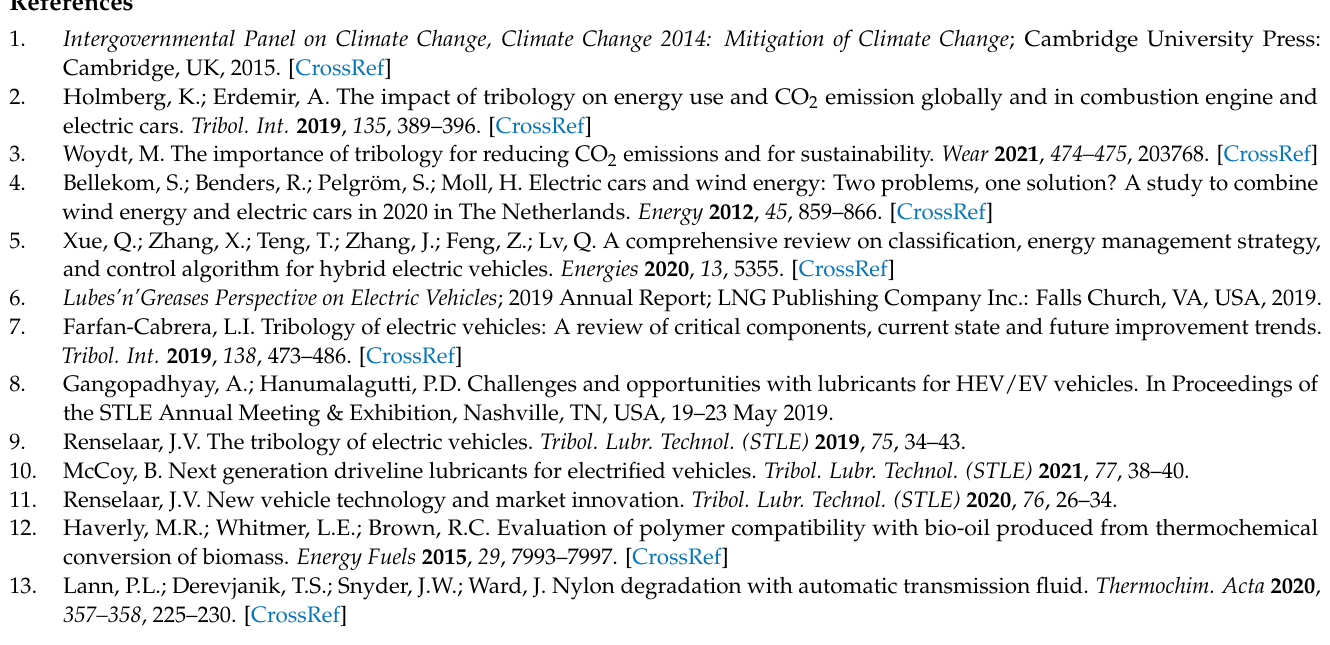
Tables S1–S3: Grubb’s statistic for every peak ratio for PEEK, PTFE and PA